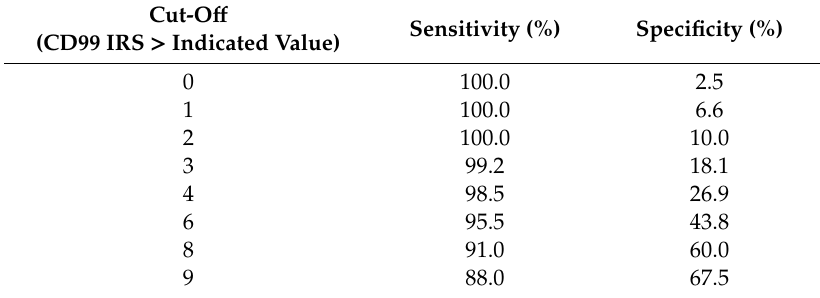
Table 2. Sensitivity and specificity of CD99 immunoreactivity in EwS. IRS, immunoreactive score. Cut-O ff Sensitivity (%) Specificity (%) (CD99 IRS > Indicated Value) 0 100.0